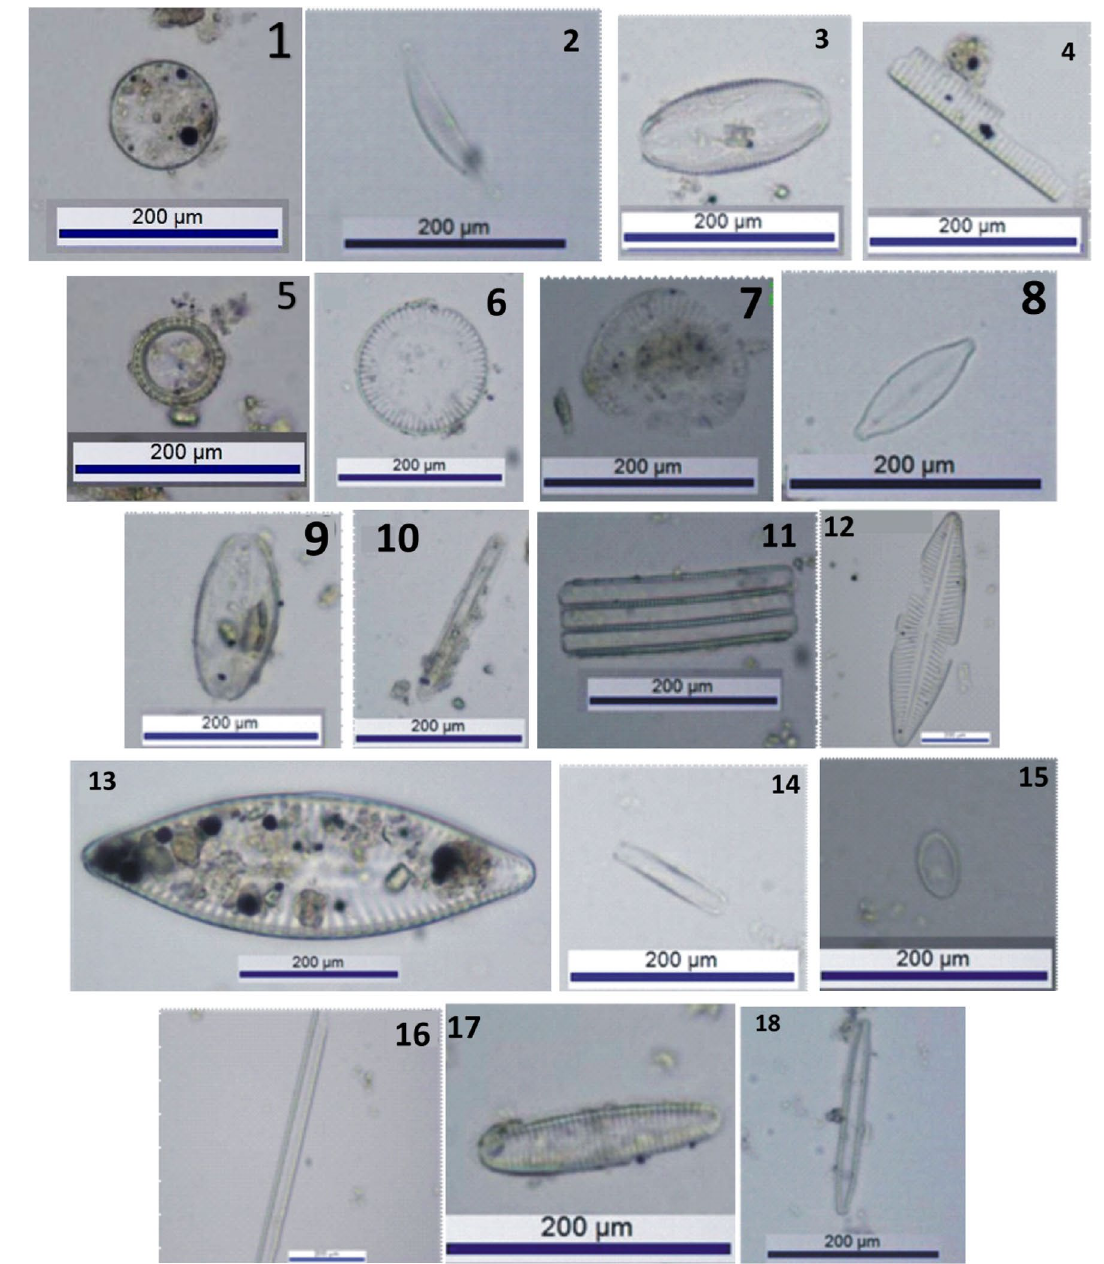
Fig. 5 Diatom species observed in Akkulam-Veli lake sediments. (1) Actinocyclus normanii , (2) Amphora holsatica , (3) Amphora ovalis , (4) Ardissonea sp., (5) Cyclotella atomus , (6) Cyclotella meneghini- ana, (7) Cyclotella striata , (8) Diadesmis confervacea , (9) Diploneis